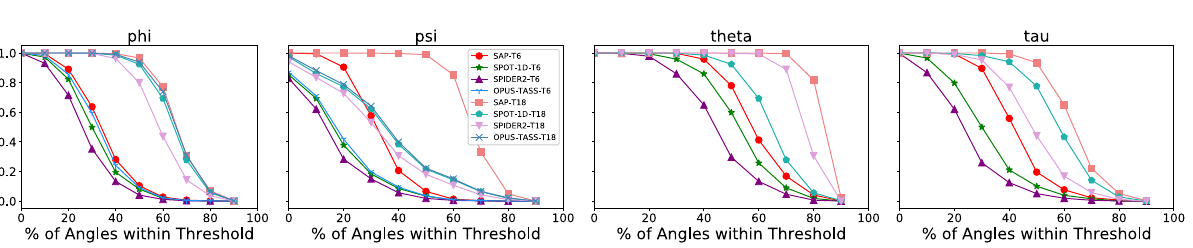
Figure 7. Percentages of proteins (y-axis) that have a given percentage of residues (x-axis) with AE at most a given threshold T where T is 6 and 18 and are denoted by T6 and T18. The lower the threshold, the better the prediction quality.